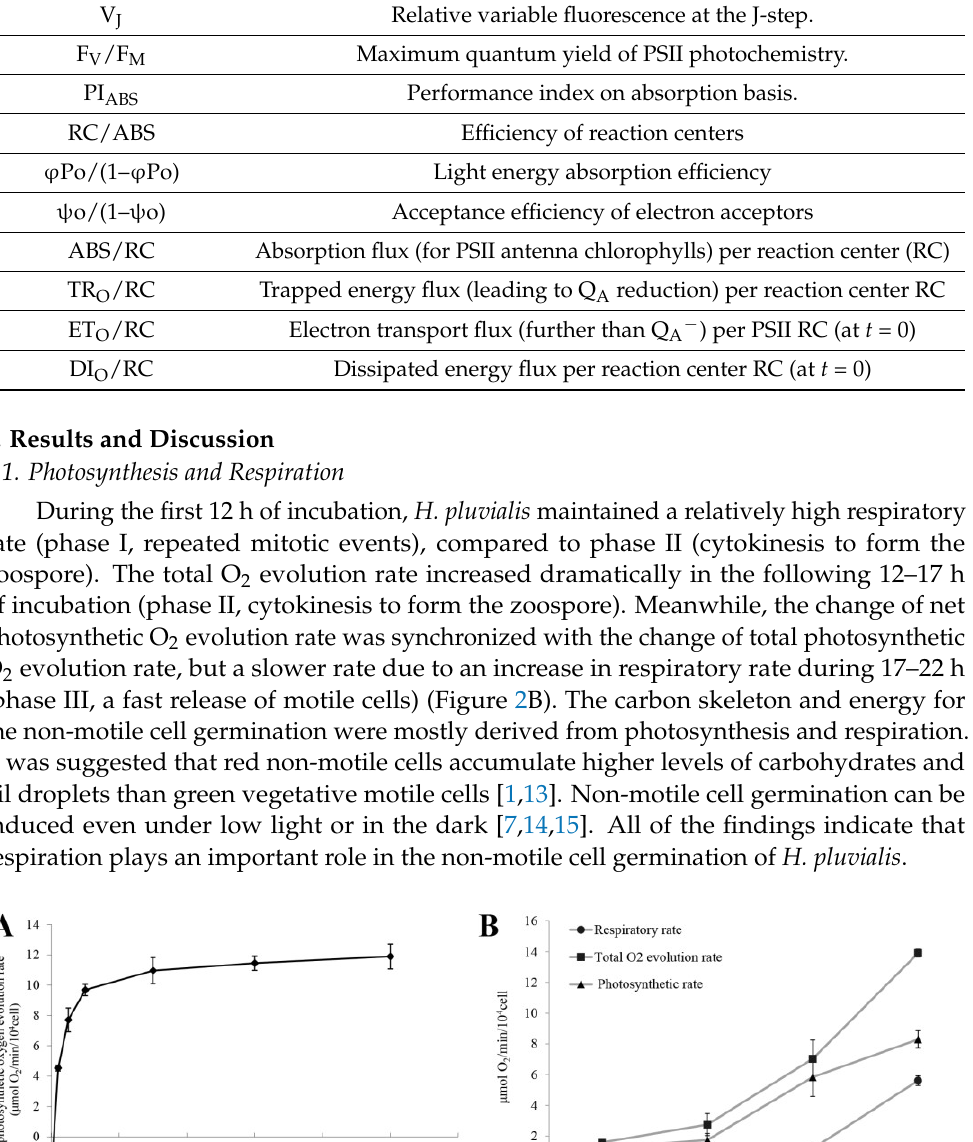
Table 1. Definitions and explanations of selected JIP-test parameters derived from the chlorophyll a fluorescence induction curve. Parameters Description V J Relative variable fluorescence at the J-step. F V /F M Maximum quantum yield of PSII photochemistry. PI ABS Performance index on absorption basis.